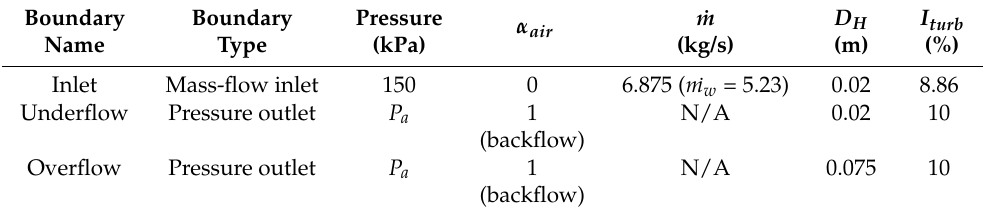
Table 3. Flow boundary conditions.